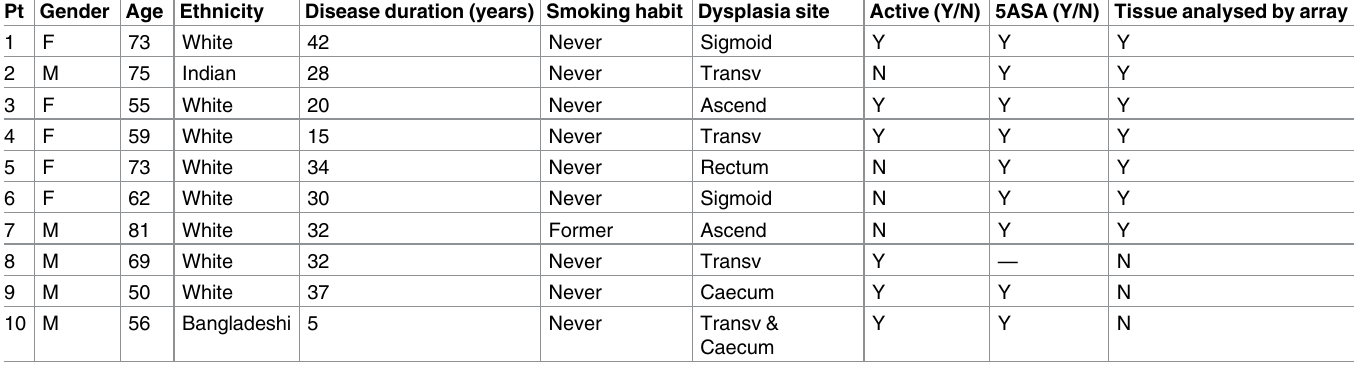
Table 1. Characteristics of ulcerative colitic patients from whom a dysplasia specimen was obtained. All were from patients classifiedas Montreal E3. Pt Gender Age